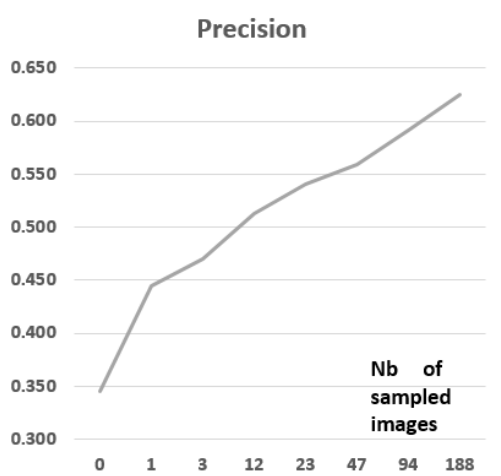
Figure 13. Segmentation precision for different numbers of sampled images from the target domain.